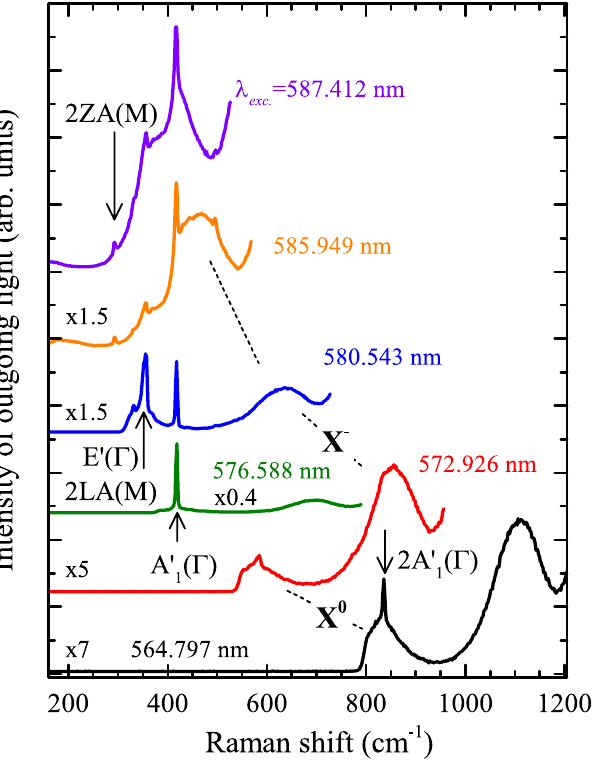
Figure 4. Optical response of monolayer WS 2 excited at T = 5 K with laser light of different